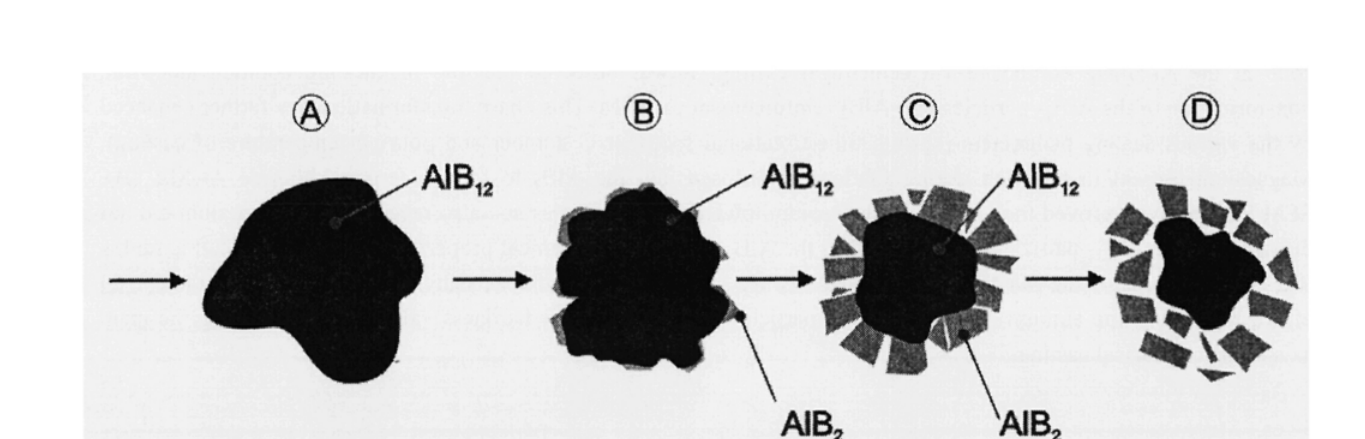
Fig. 14: Phase morphology of the aluminum boride particles in Al-B-Mg composite melt during centrifugal casting. The role played by the centrifugal casting parameters can provide more explanation on the phase transformation kinetics involved as the particles move from the inner zones of casting towards the outer periphery. This is further documented elsewhere /IS/. Since the transformation stages happened in short time or even simultaneously one might not be able to differentiate the phase change from the diffusion stage. The micrographs (Figures 3, 5 and 7) also corroborated the transformation of the A1B large particles into more faceted but smaller A1B particles. )2 2 To demonstrate the effect of Mg in favoring the dodecaboride decomposition, we tested the Al-B master alloy (Al-7.2wt. %B) by melting and heat treating it (Figure 15a though c). Figure 15a shows the microstructure of the master alloy as provided. Figures 15b and 15c show the microstructure of the master alloy after annealing at 400°C for 25 minutes and after holding the molten alloy at 850°C for same time. It is evident that boron remains present as AlBi . 2 After the 400°C annealing it is apparent that the A1B, phase still retains its morphology without the presence of 2 diborides. The melt treatment did not cause the transformation of the A1B phase of the master alloy (Figure 15c) only )2 agglomeration. This is in agreement with literature information suggesting that the phase transformation occurs at higher temperatures above 900°C in binary alloys